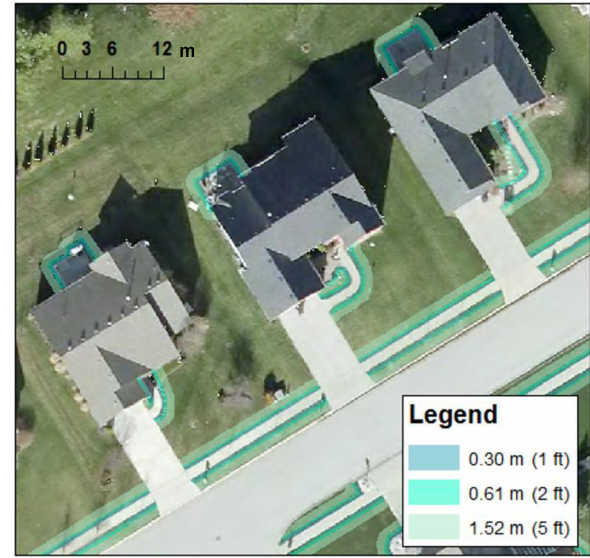
Figure 3. Depiction of the different distances applied for the esti- mation of BPA in the baseline condition using